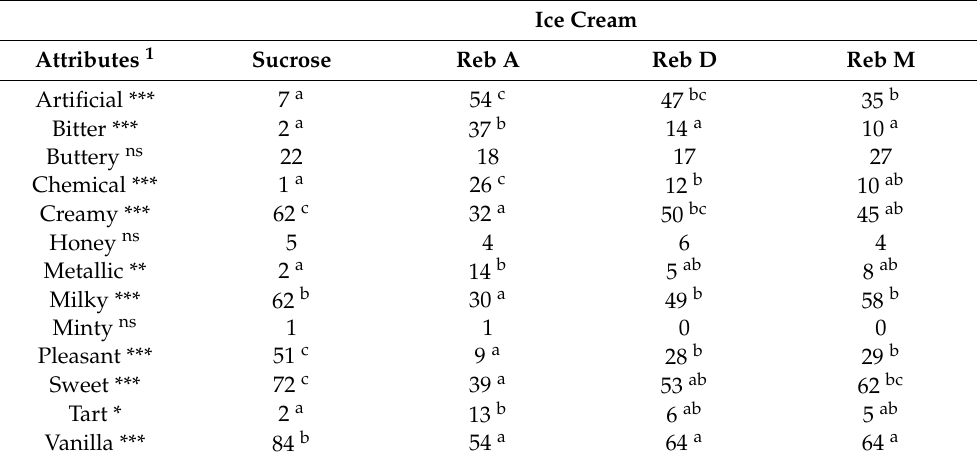
Table 8. Aftertaste attributes selected by the consumer panel for sucrose, Reb A, D, and M ice cream ( n =